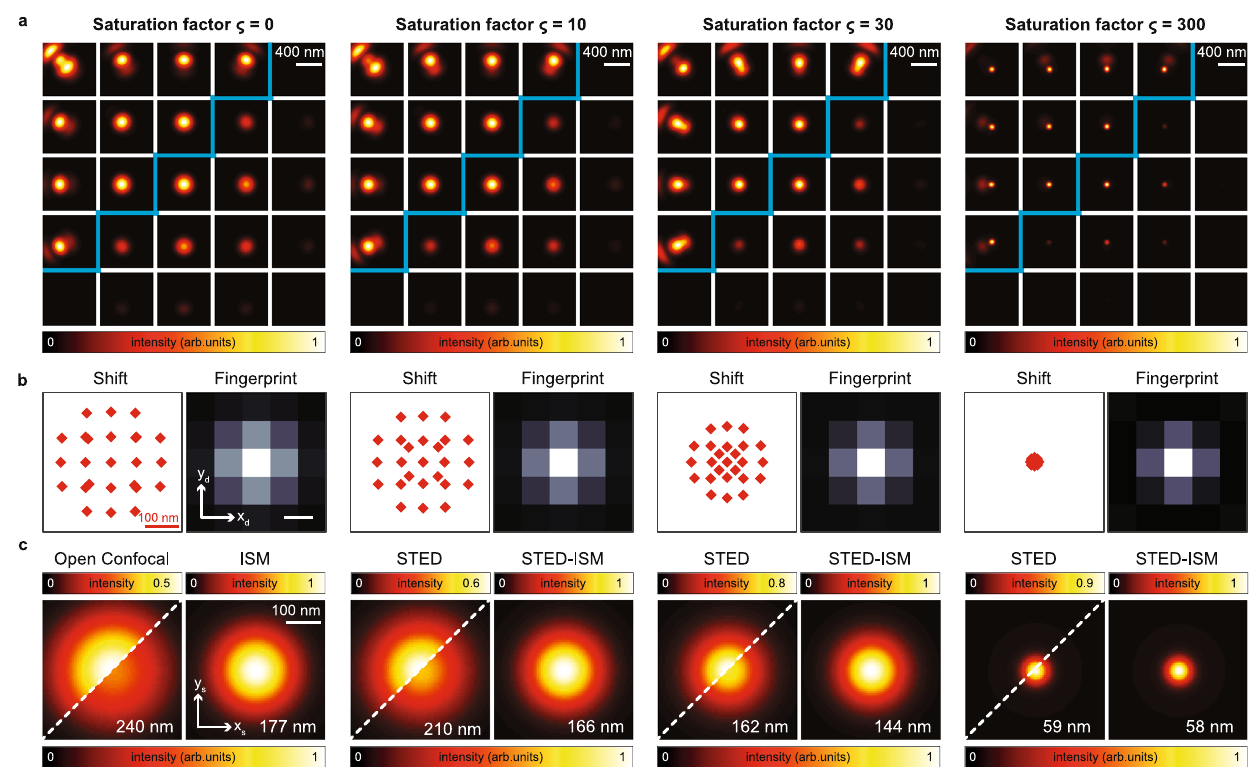
Fig.2|STED-ISMprinciple. In( a ),weshowsimulatedimagesofthePSF h ( x s ∣ x d )for each detector element. In ( b ), we show the shift vectors, calculated using the adaptivepixelreassignmentalgorithm,andthe fi ngerprint,calculatedbysumming all the x s points of the above images. In c , we compare the PSF obtained with a single-element detector (open pinhole con fi guration) with the PSF reconstructed